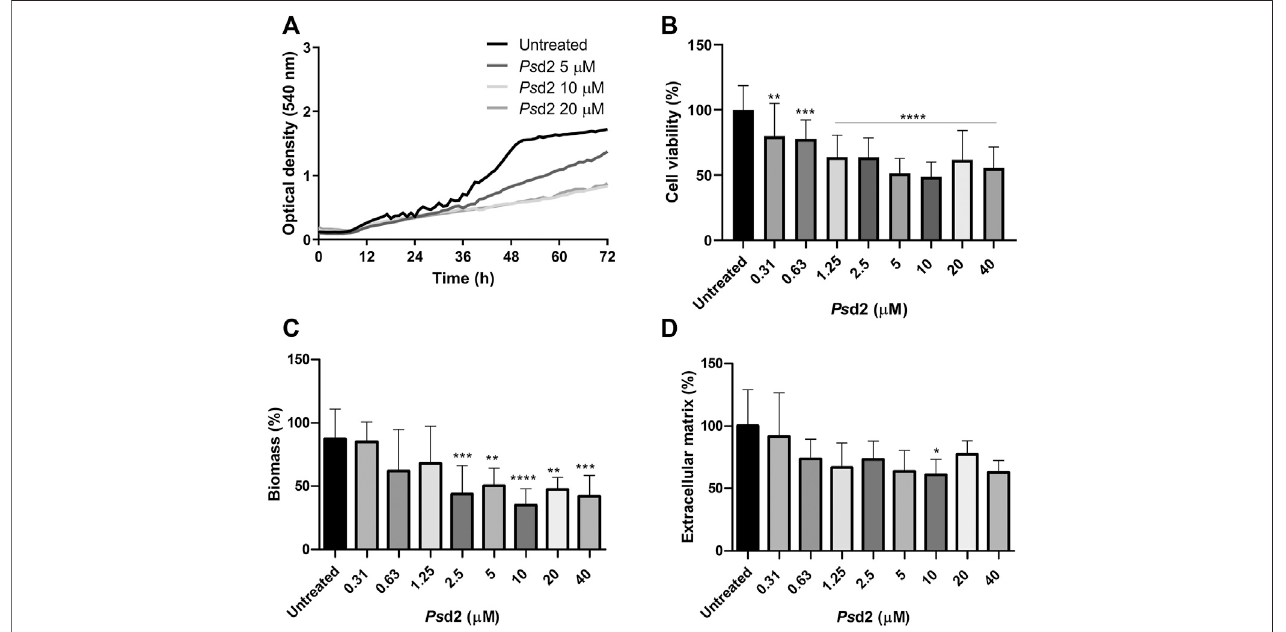
FIGURE4| Effectof Ps d2defensinin A.nidulans bio fi lmformation. (A) Kineticsofbio fi lmformationmeasuredbyopticaldensityover72 h. (B) Quanti fi cationofcell viabilitybyXTT-reductionassay. (C) Quanti fi cationofglobalfungalbiomassbycrystalvioletassay. (D) Quanti fi cationoftheextracellularmatrixproducedwithsafraninO. The error bars represent standard deviations of the mean of four independent experiments performed in triplicate. Signi fi cant differences ( p < 0.05) are represented by asterisks when the Ps d2 concentrations were compared to the untreated control; * p < 0.05; ** p < 0.01; *** p < 0.001; **** p <